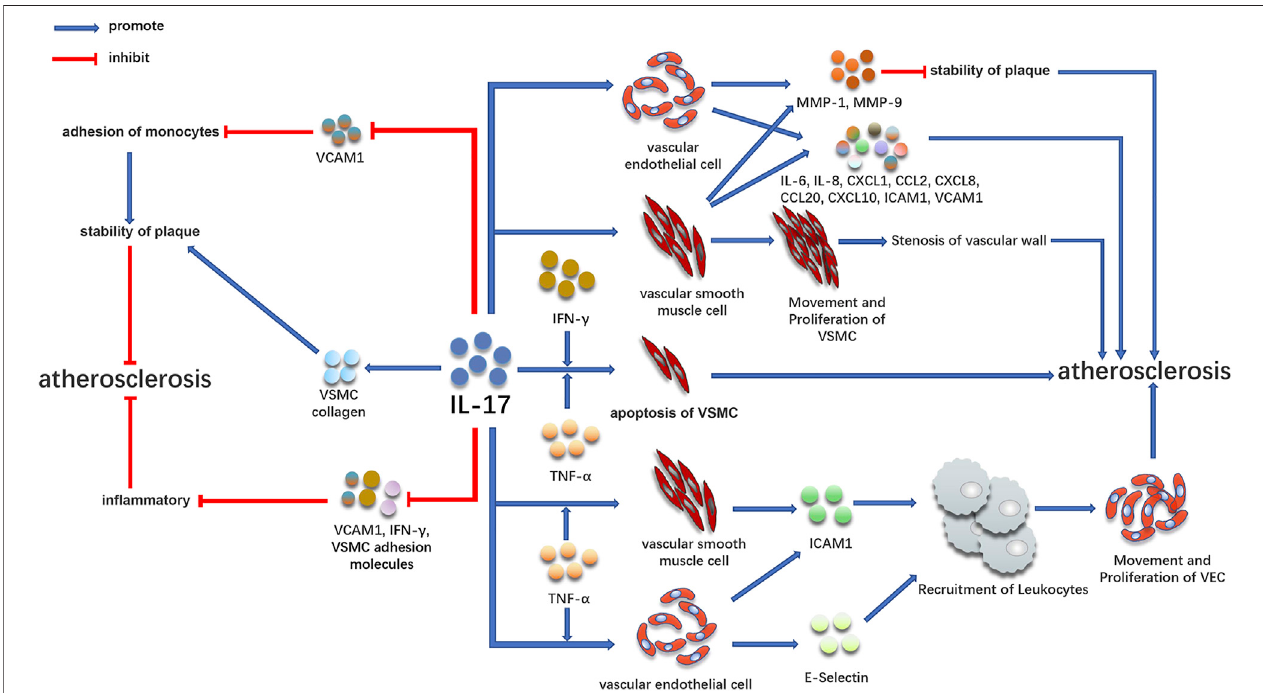
FIGURE2| PromotingandinhibitingeffectofIL-17inatherosclerosis.IL-17isinvolvedinthedevelopmentofatherosclerosisbyactingonvascularendothelialcells andVSMC.Atthesametime,IL-17canplayananti-atheroscleroticeffectbyincreasingplaquestabilityandinhibitingin fl ammation,whichmayberelatedtothestagingof the